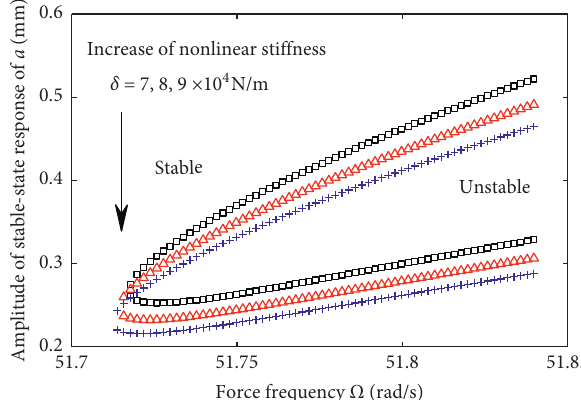
Figure 6: Effectofnonlinear